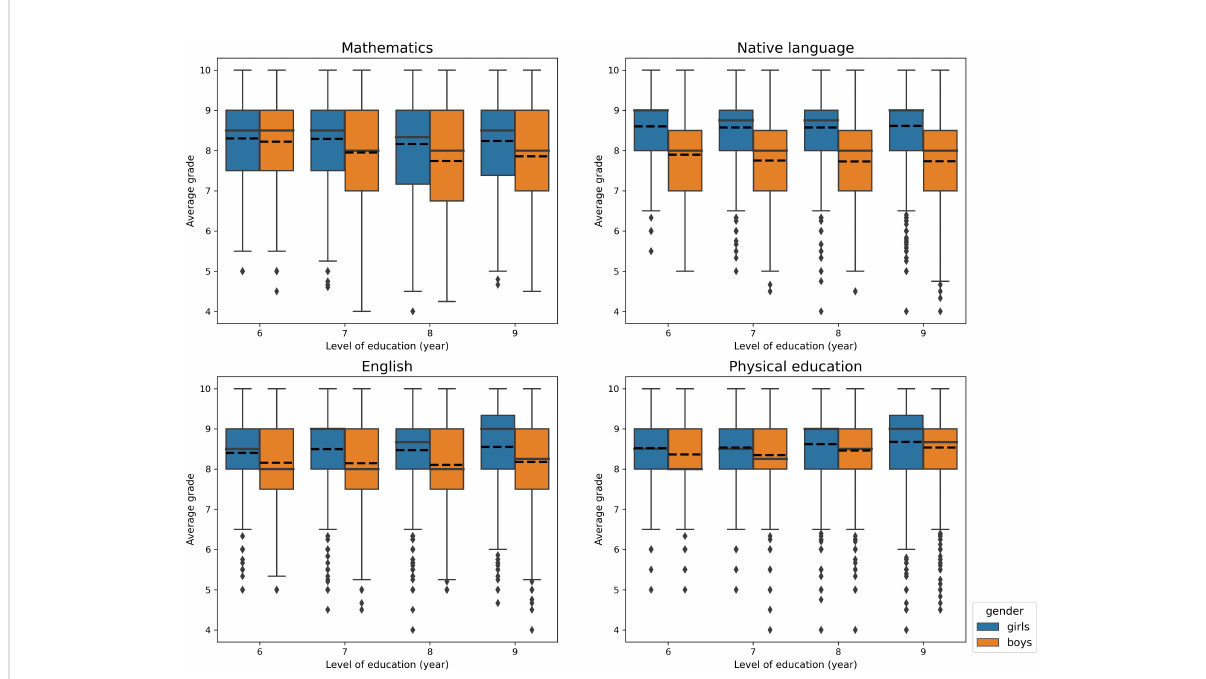
FIGURE 3 Boxplot of school performance in years 6,7,8 and 9 separately for girls and boys. The dotted line shows the mean and the solid line the median. Girls outperformed boys in all years and subjects statistically signi fi cantly